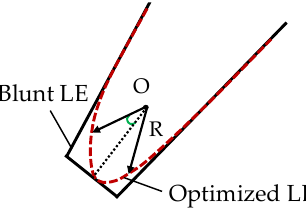
Figure 21. The parameterization of the eroded leading edge to be optimized.